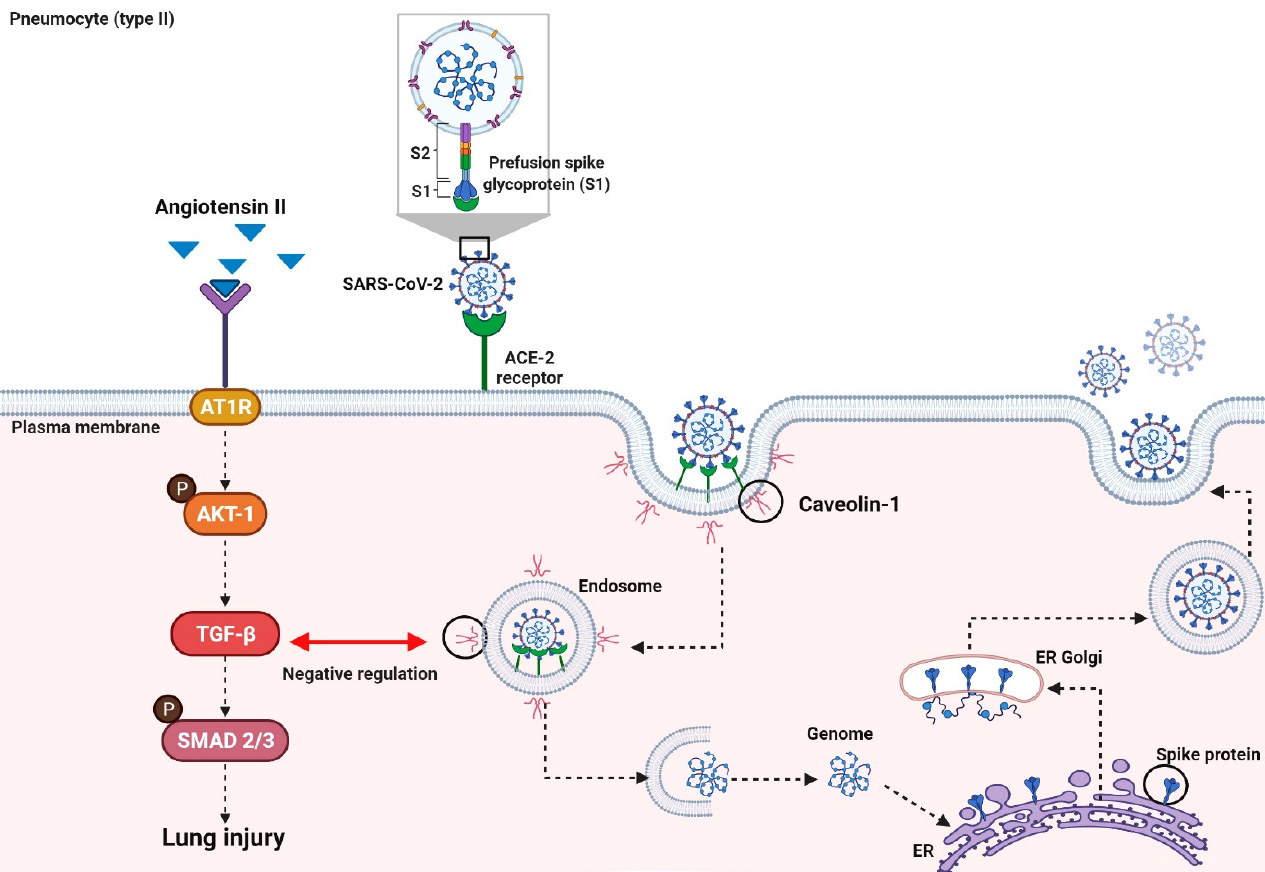
Figure 4. Virally Mediated Fibrogenic Pathways. The entry of SARS-CoV-2 into the host cell is dependent on ACE-2 receptors. The high-affinity binding between the S-Spike protein and ACE-2 receptors can trigger an imbalance of the RAS system, resulting in the accumulation of Ang II. When Ang II binds to the ATR1 receptor, it activates the PI3K/AKT pathway. TGF- β 1 consequent activation triggers the SMAD2/3 pathway, which provides proliferation and differentiation of fibroblasts. Viral infection endosomal route involves Cav-1 and ACE-2 on the lipid rafts. Cav-1 is also involved in the negative regulation of the TGF- β pathway. The physical interaction of Cav-1 and TGF- β receptors on the lipid rafts results in the internalization and degradation of this receptor, culminating in a reduction in TGF- β